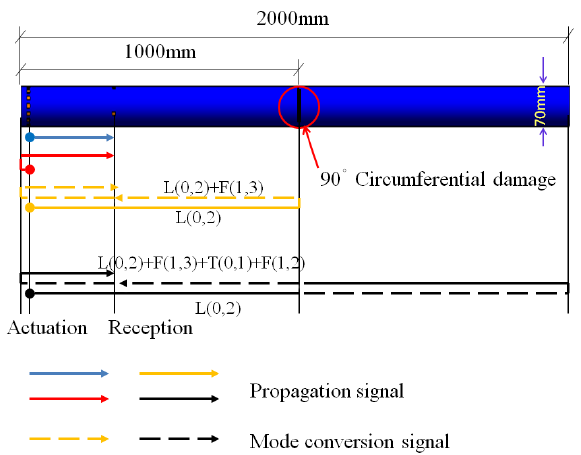
Figure 25. The received signal for the pipe with circumferential damage of 90° in the experiment.